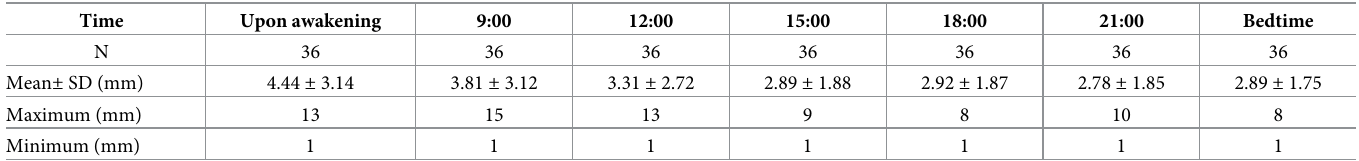
Table 1. Results of tear strip meniscometry. Upon